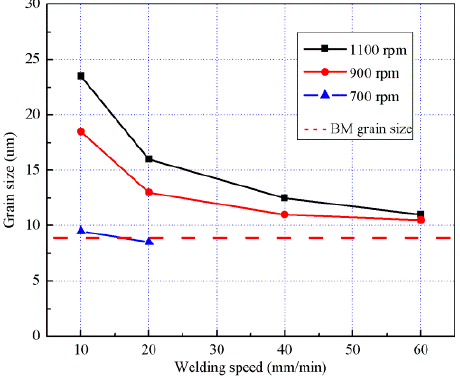
Figure 12. E ff ect of parameters on the average grain size of stir zone Figure 12. Effect of parameters on the average grain size of stir zone (SZ).